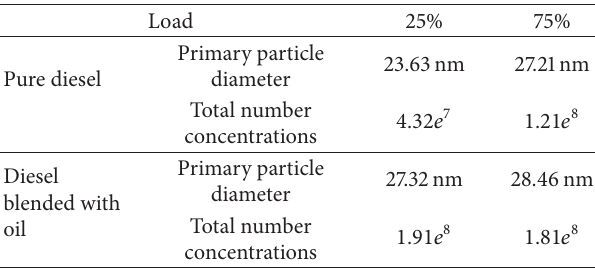
Table 1: Particles formation